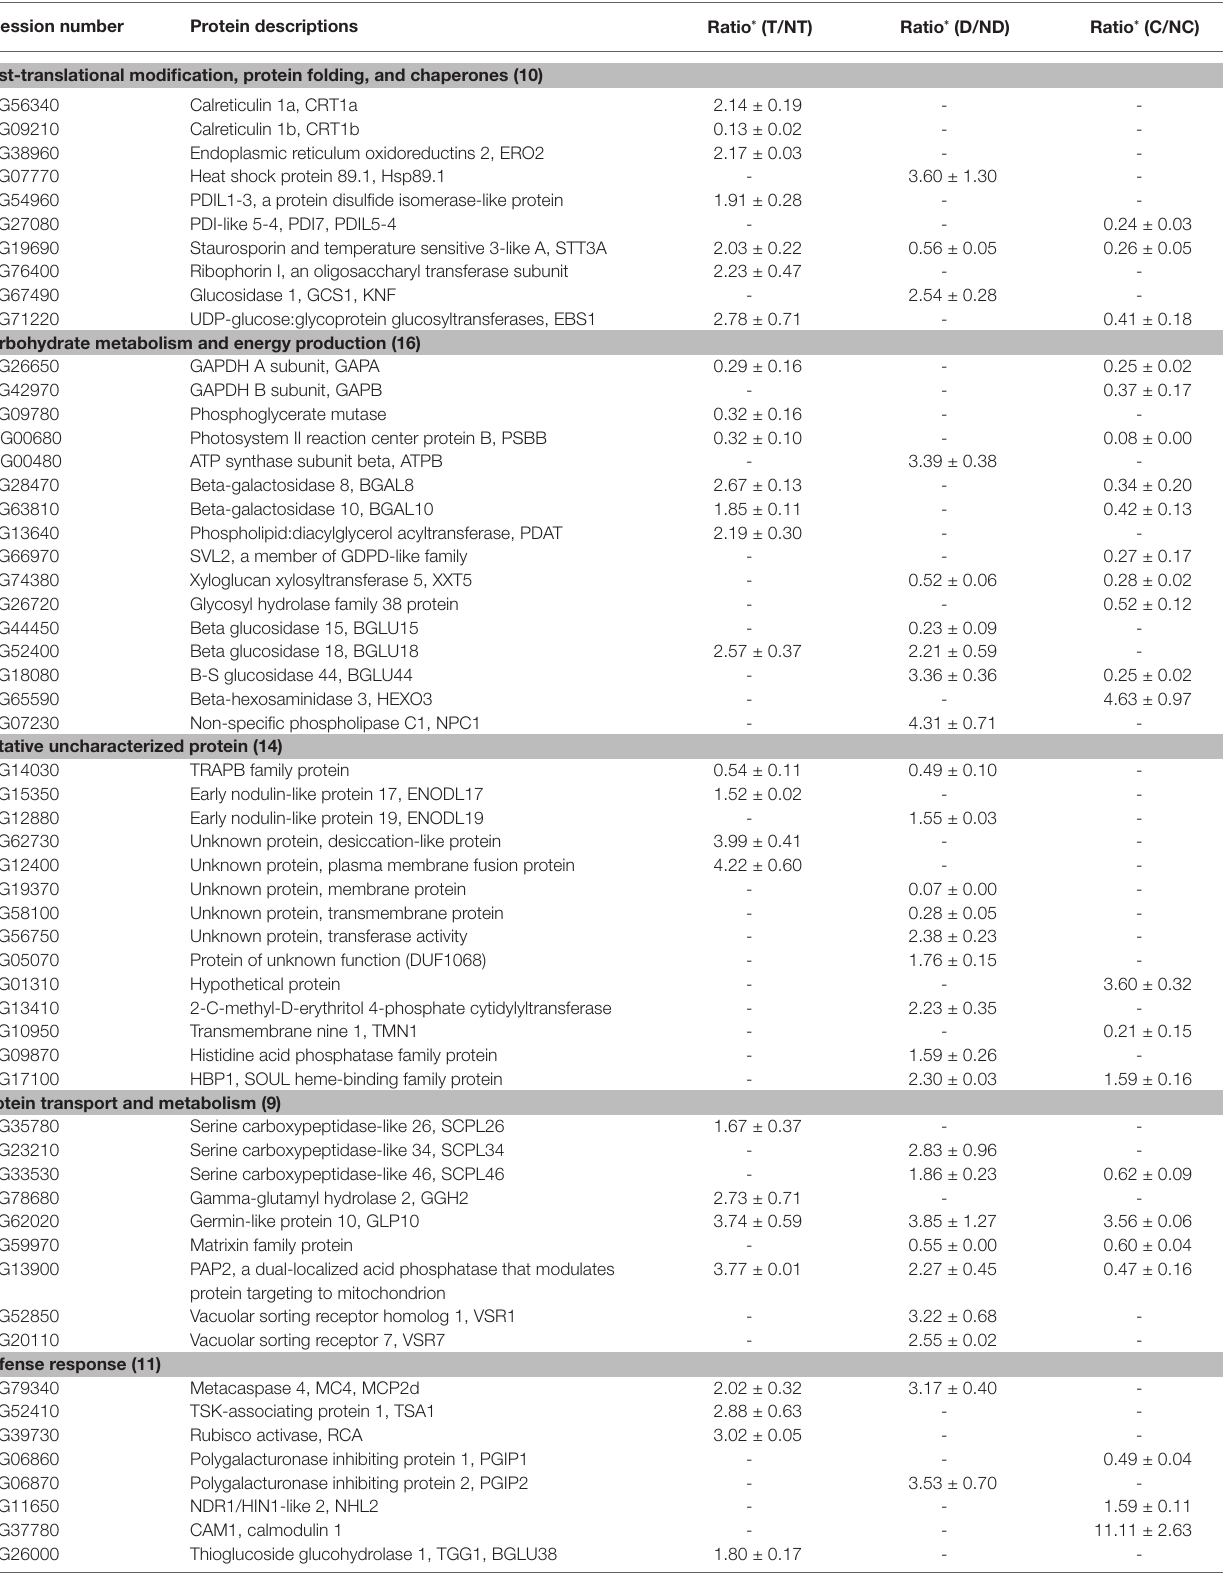
TABLE 2 | Differentially abundant glycoproteins were identified in the WT, mns1 mns2 , and cgl1-3 in response to salt